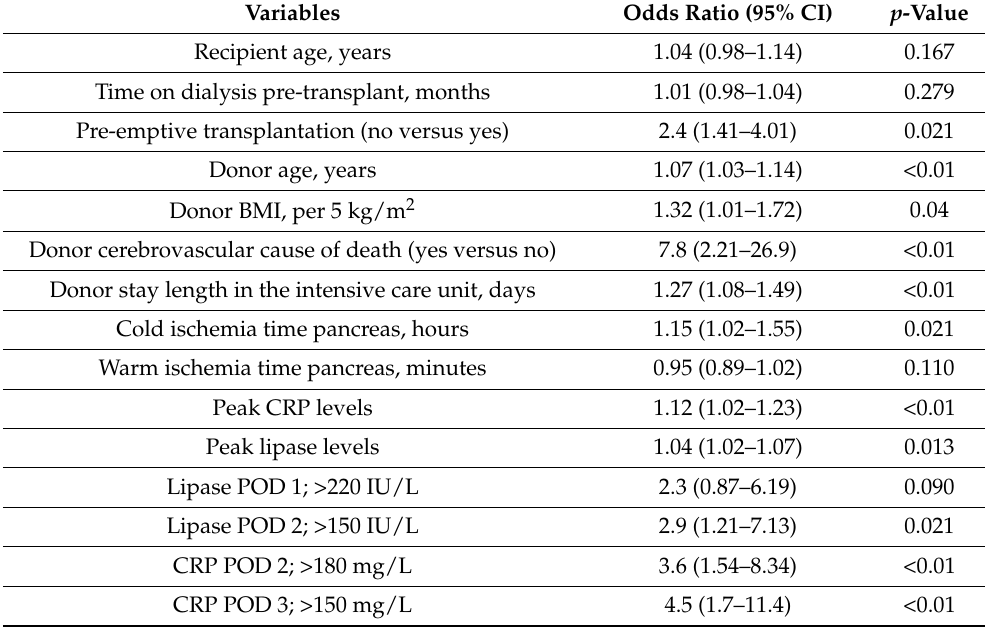
Table 7. Multivariate logistic regression analysis of factors correlated to the occurrence of early pancreatic graft dysfunction following